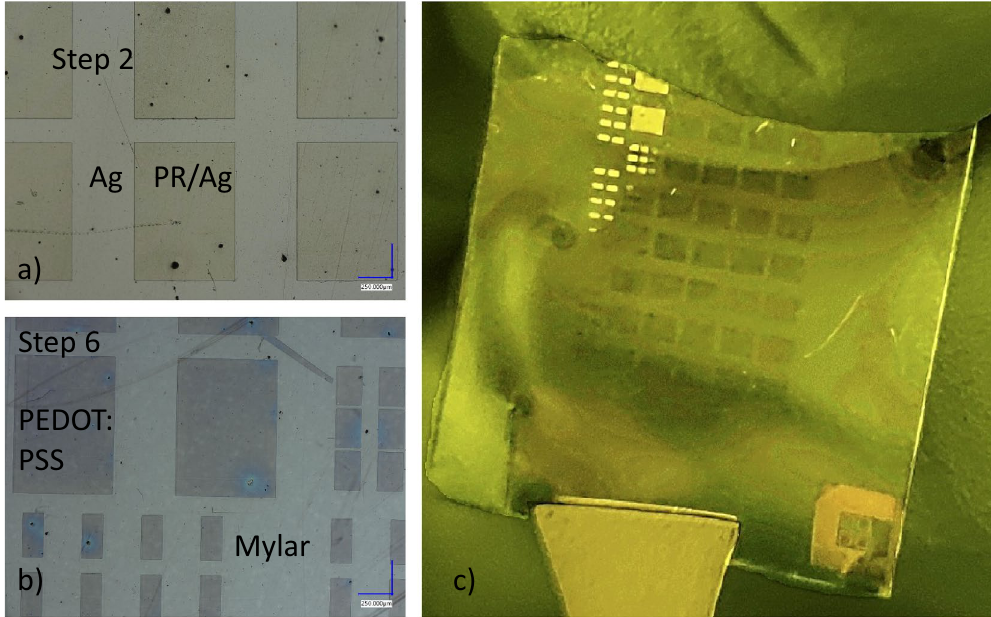
Figure 3. PEDOT:PSS patterning on Mylar flexible substrate. ( a ) patterning of the photoresist of the layer stack PR/Ag/PEDOT:PSS/Mylar. ( b ) The final PEDOT:PSS patterns on Mylar. ( c ) 2 × 2 cm piece of Mylar with PEDOT:PSS patterns on it.